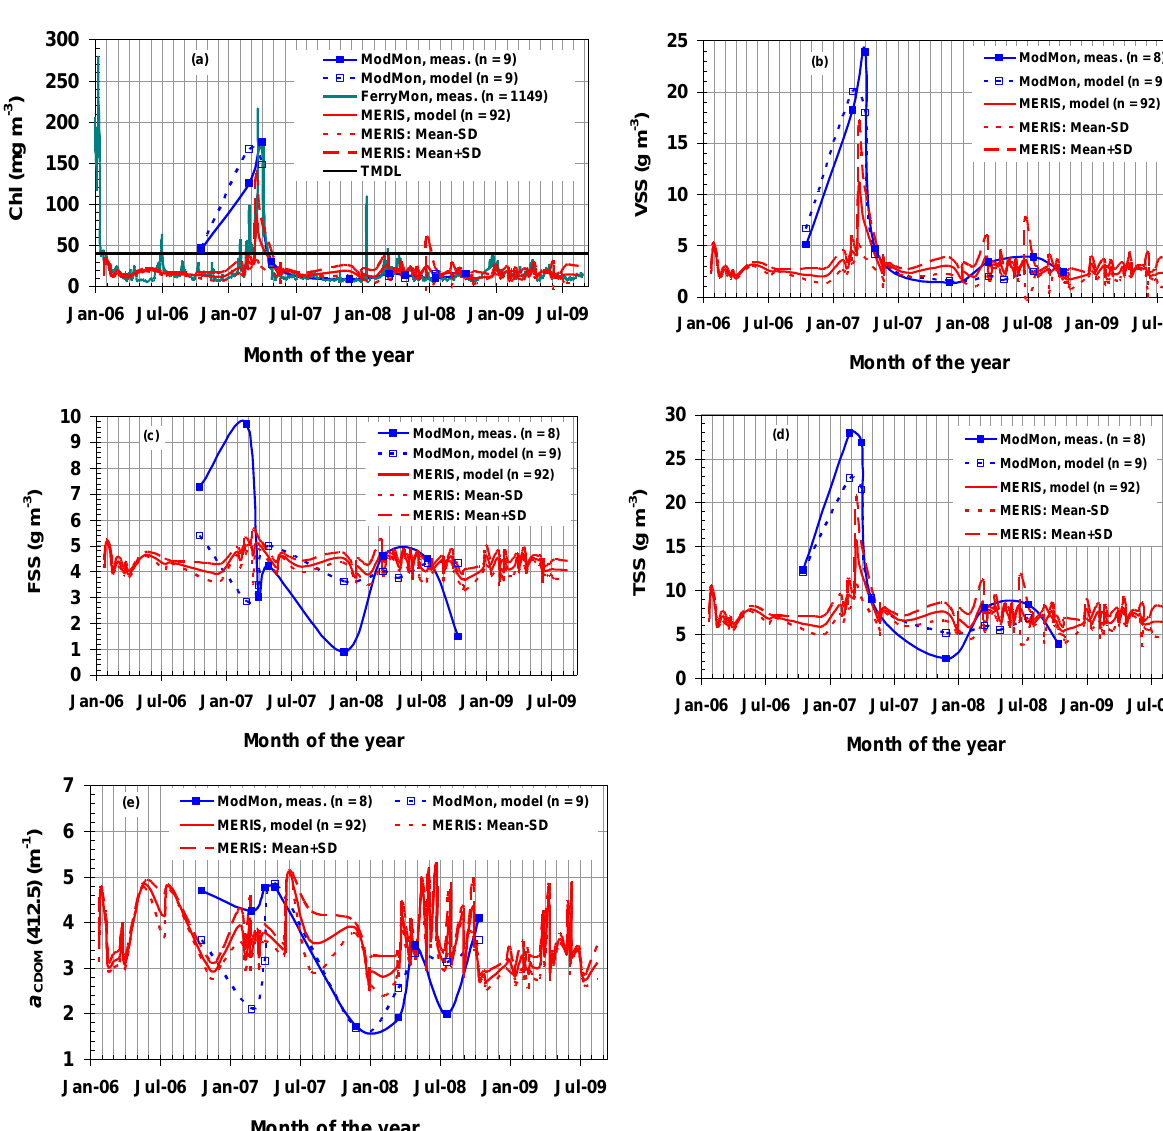
Figure 5. Seasonal dynamics of daily-averaged WQCs in NRE (2006–2009) for Chl (a) , VSS (b) , FSS (c) , TSS (d) and a (412.5) (e) . FerryMon data and TMDL line are shown CDOM only for Chl, but measured and predicted ModMon and MERIS values are shown for all